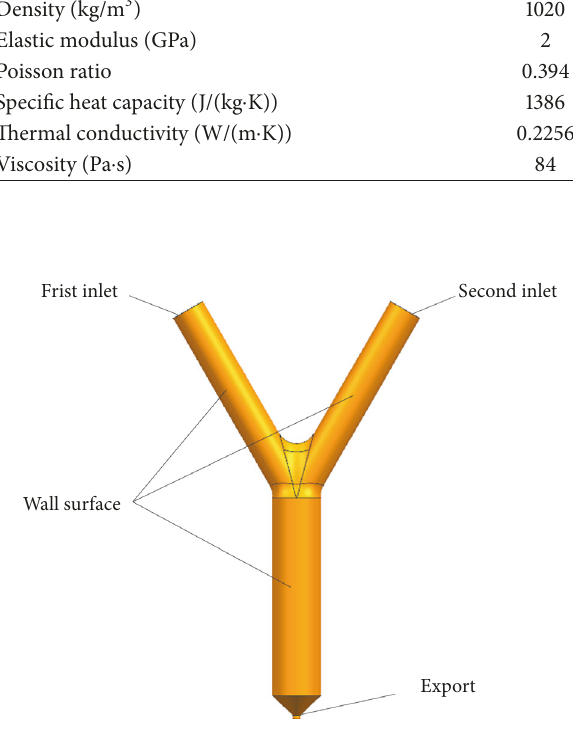
Figure 5: Boundary conditions of the flow channel